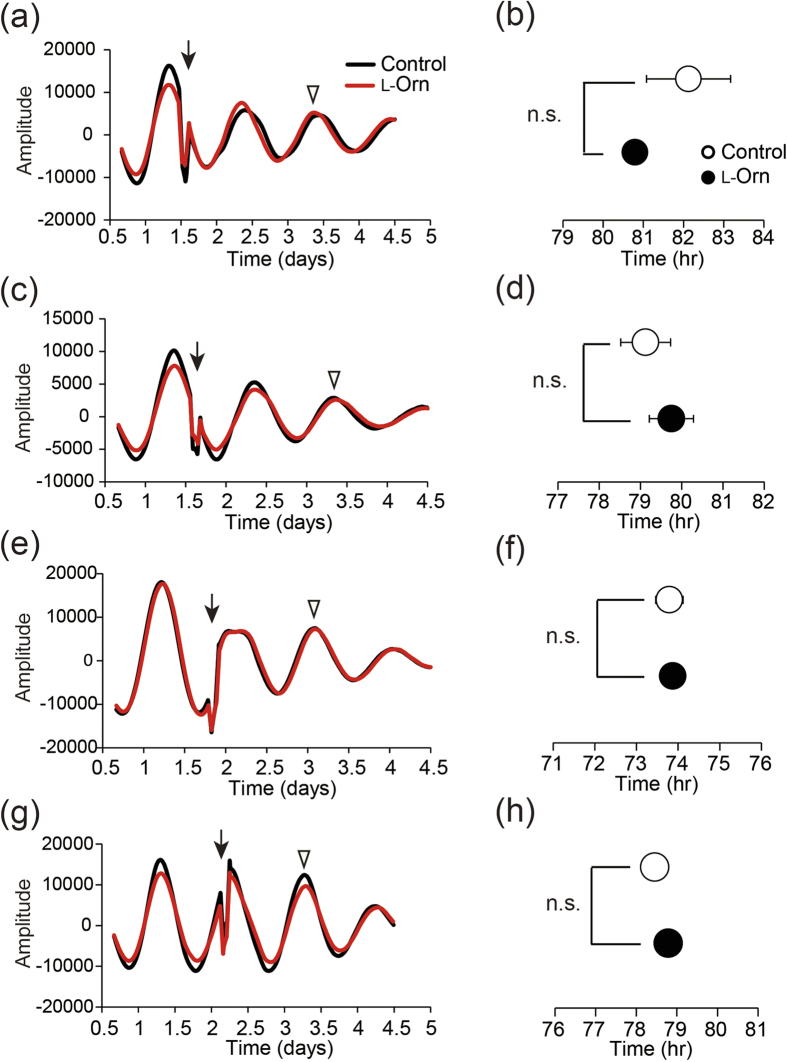
Effect of L-ornithine on PER2::LUC oscillation in MEFs.(a,c,e,g) Representative data for MEFs treated with water or 1 mM l-ornithine. Filled arrows indicate the time point of l-ornithine application; open arrowheads indicate the peak phase. (b,d,f,h) Summary of the peak phase of mPer2 expression. All values are expressed as means ± SEM (n = 4 mice per group).